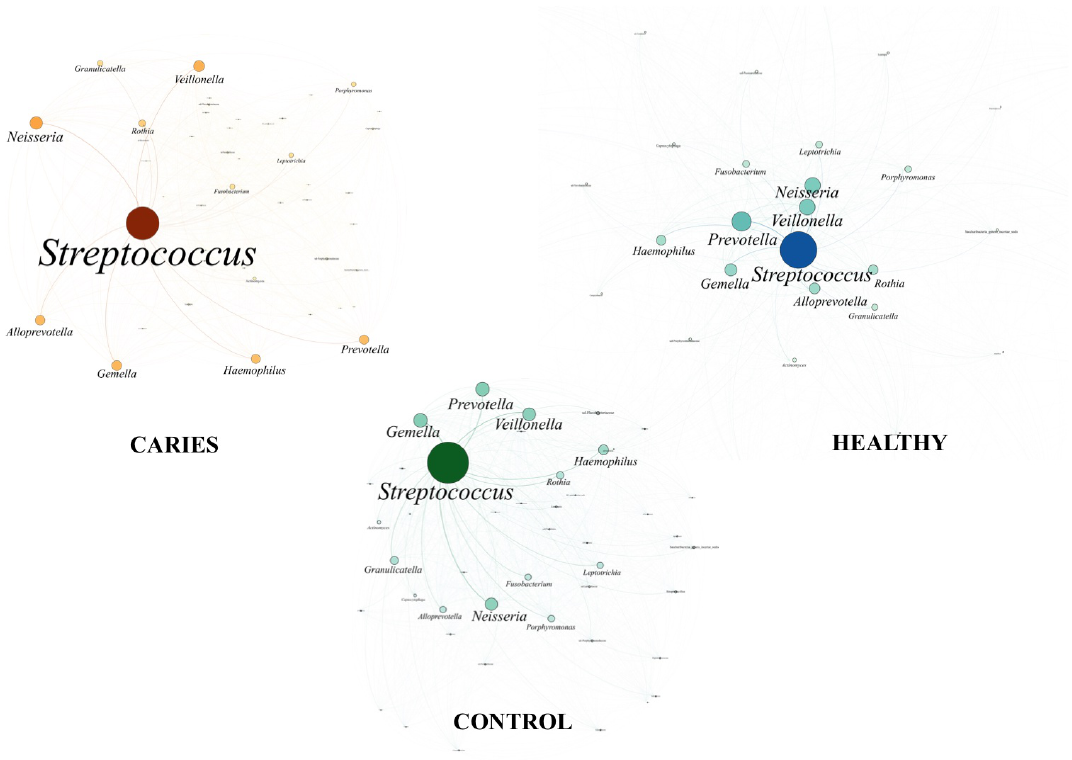
Figure 4. Complex networks core microbiota for the three differenced subjects using